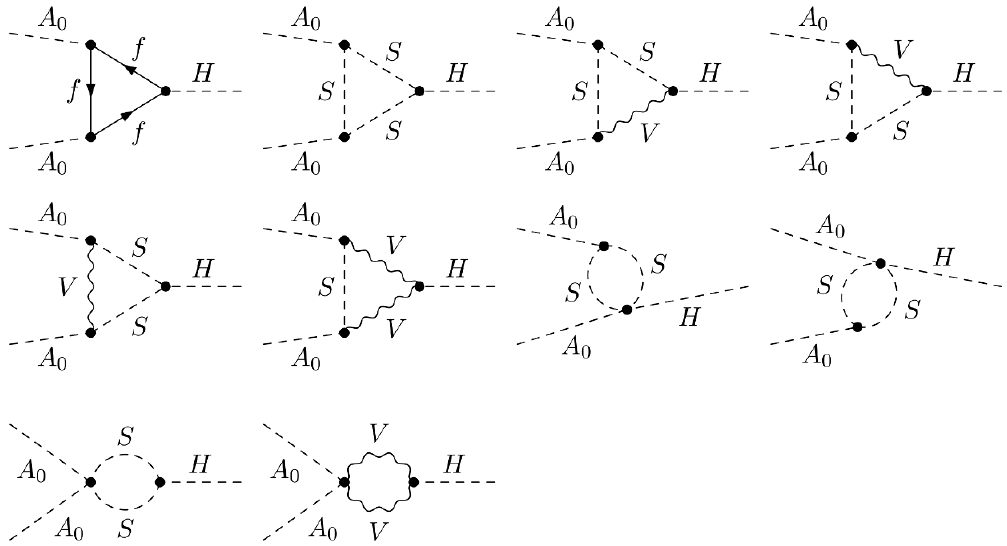
0 A 0 vertex correction used for the renormal-